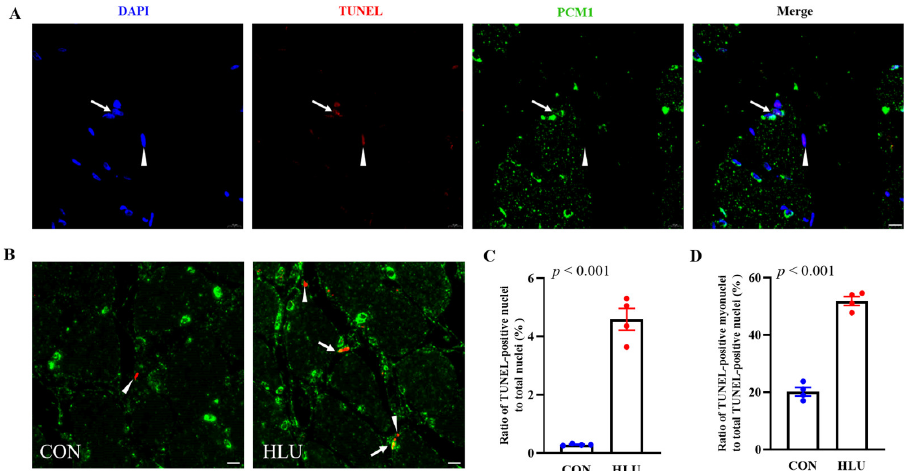
Figure 6. Ratio of TUNEL-positive nuclei and TUNEL-positive nuclei co-localized with pericentriolar material 1 (PCM1). ( A ) TUNEL assay and PCM1 immunofluorescence staining on muscle slice. Nuclei were blue after DAPI staining. TUNEL-positive nuclei were red after TUNEL staining. PCM1 was green after immunofluorescence staining. Nuclei labeled with PCM1 were myonuclei. TUNEL-positive nuclei co-localized with PCM1 (apoptotic myonuclei) were indicated by an arrow, TUNEL-positive nuclei not co-localized with PCM1 (apoptotic non-myonuclei) were indicated by an arrowhead in Merge. ( B ) Co-localization results of TUNEL assay and PCM1 immunofluorescence staining on SOL muscle slice in the CON and HLU groups. ( C , D ) Percentage of TUNEL-positive nuclei to total nuclei, and percentage of TUNEL-positive nuclei co-localized with PCM1 to total TUNEL-positive nuclei. Each circle representde a value. n = 4. Data were analyzed by t -test. Data are